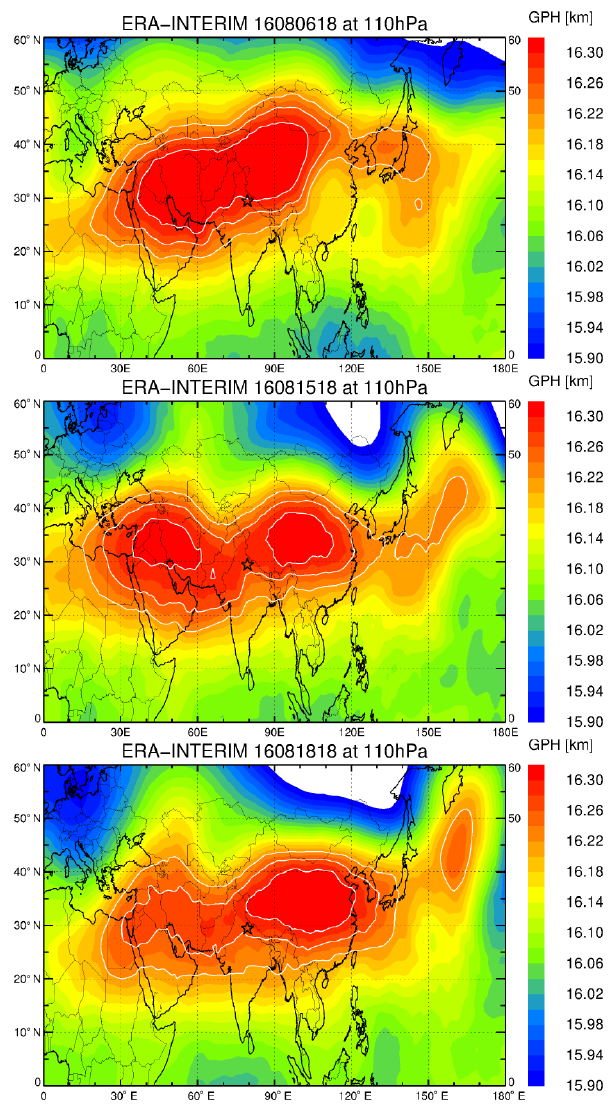
Figure 3. Location of the Asian monsoon anticyclone measured by the geopotential height at 110hPa for 6, 15 and 18 August 2016 at 18:00UTC (corresponding to 23:30IST (Indian standard time) in Nainital). The GPH of 16.22, 16.26 and 16.30km is shown as white contour lines. The location of Nainital is marked by a black star